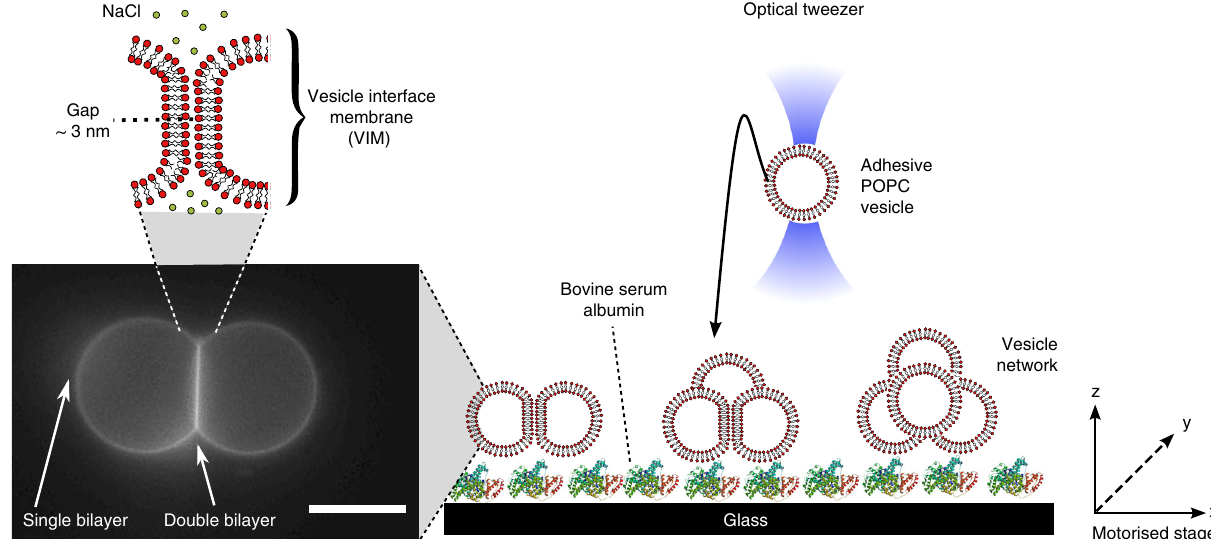
Fig. 1 Schematic of setup for the controlled assembly of vesicle networks of user-de fi ned architectures. The presence of 0.75 M NaCl in the external solution yielded adhesive vesicles that could be manipulated in 3-D using an optical tweezer and a motorised stage. System components are not drawn to scale. Vesicle = c. 5 µ m radius, laser beam waist = c. 1 µ m. Scale bar = 10 µ